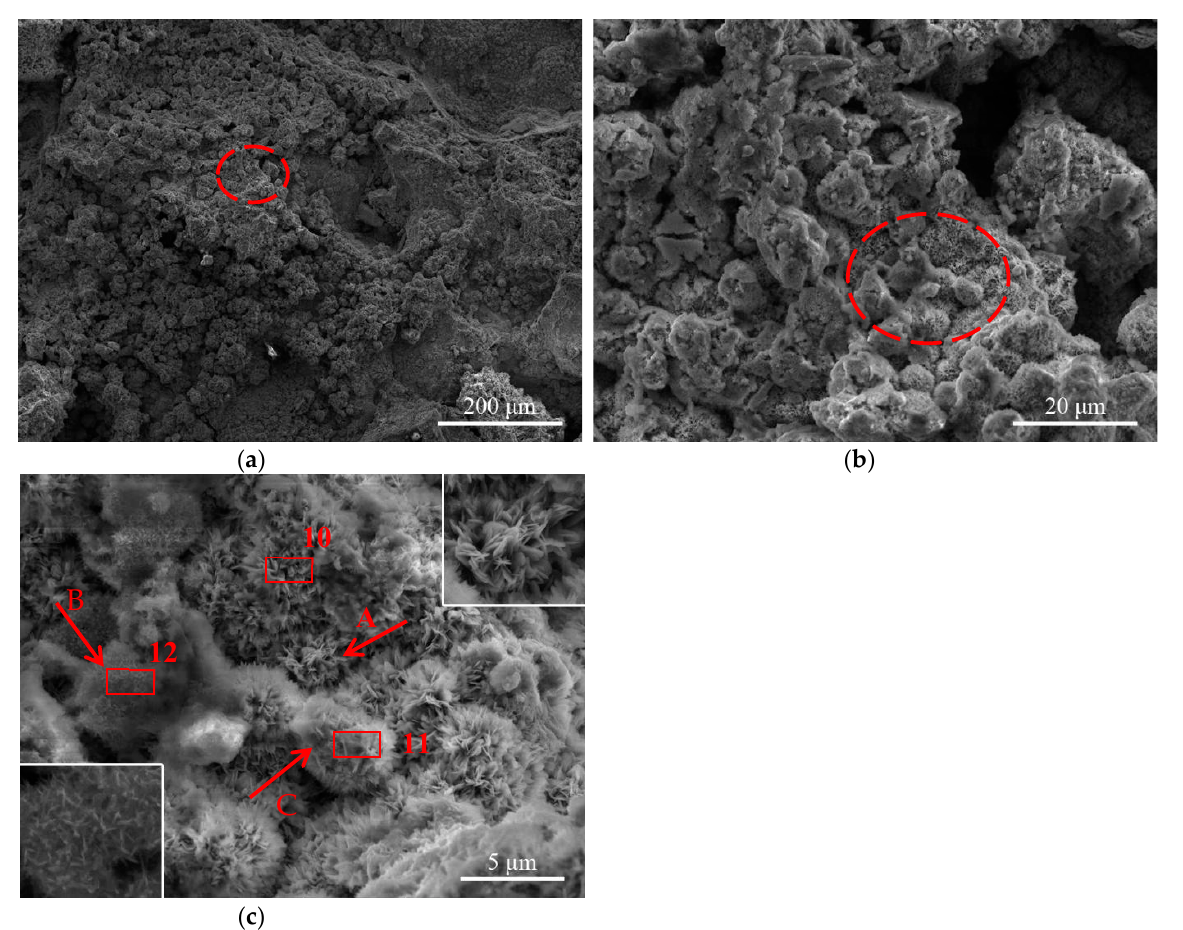
Figure 6. Surface microscopic morphologies of the rust layer and EDS analyses after 41 months of atmospheric exposure.